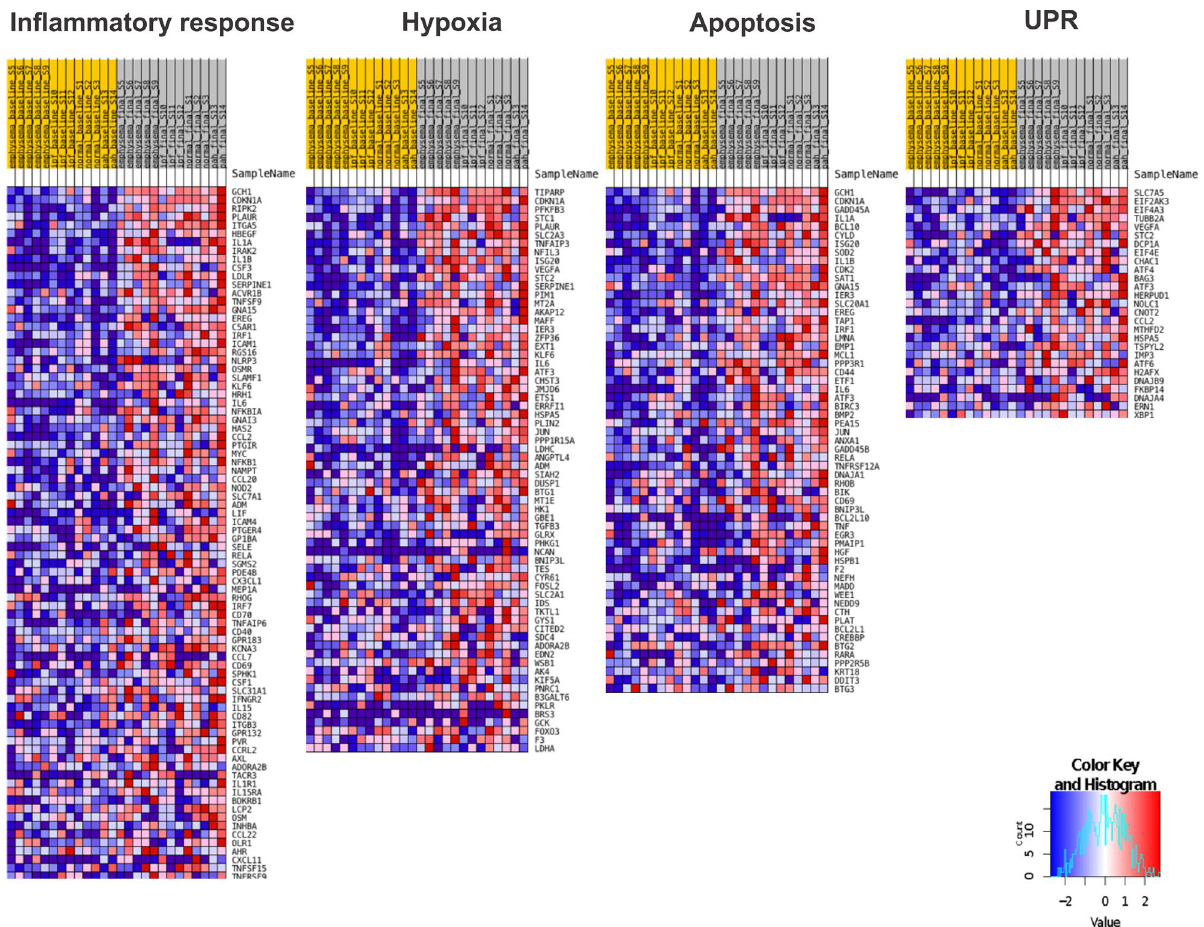
Figure 8. Heat maps for differentially expressed genes (DEG) in Inflammatory Response, Hypoxia, Apoptosis, and UPR pathways. Top differentially expressed genes in the Inflammatory Response, Hypoxia, Apoptosis, and UPR pathways at baseline (yellow) and final state (grey) of EVLP for all group samples (Normal, Emphysema, IPF, and PAH). ( A , C ) FDR adjusted p value < 0.05. ( B ) raw p value < 0.01 and |logFC|>